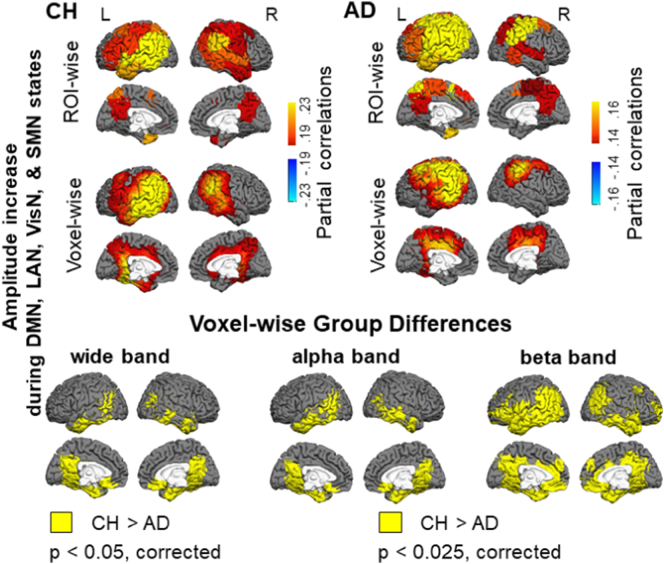
Maps of effects specific to a combined set of four HMM states, including the DMN, LAN, VisN, and SMN. ROI-wise maps on the very top show consistent enhancements (in yellow/red/brown colors) in oscillatory amplitudes during these network states, as quantified by partial correlations between the aggregate four-state time-course and the oscillatory amplitude envelopes in a priori ROIs. Directly below are the corresponding maps at the voxel-wise resolution, as quantified by partial correlations between the aggregate four-state time-course and the oscillatory amplitude envelopes in individual brain voxels. Maps in the CH group are on the left, and maps in the AD group are on the right. The bottom panel shows voxel-wise group differences. Brain voxels where the amplitude enhancement during the four network states was reduced in the AD relative to CH group are shown in yellow color in the wide band (4–30 Hz) in the left panel (p < 0.05, corrected), in the alpha oscillatory band (8–12 Hz) in the central panel (p < 0.025, corrected), and in the beta band (15–30 Hz) in the right panel (p < 0.025, corrected). Color scales and abbreviations are the same as in Fig. 2.